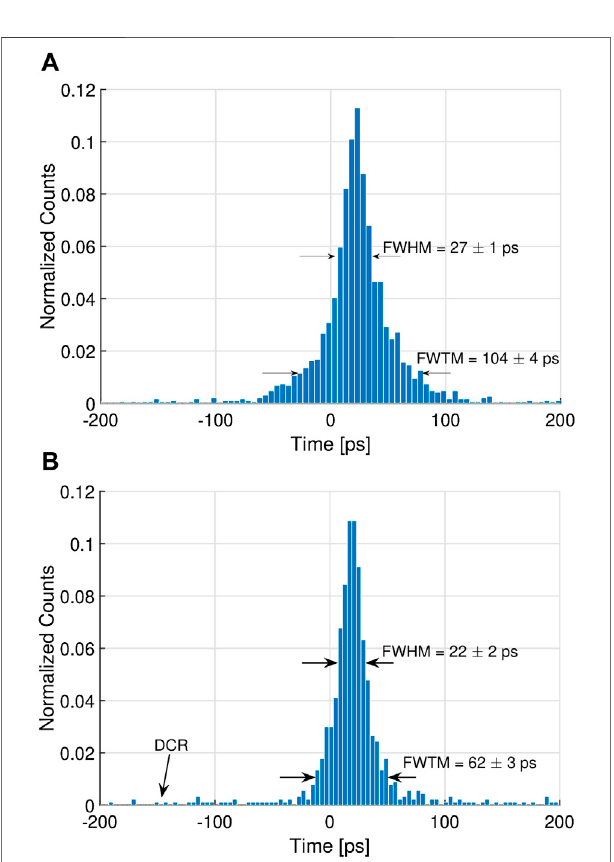
FIGURE 8 | Normalized distribution of the MIP time-of- fl ight between two SPADs in coincidence. (A) at 24 V and (B) at 27 V bias voltage. achieved with a serial bus interface that allows the tuning of the device operating point from an host computer.